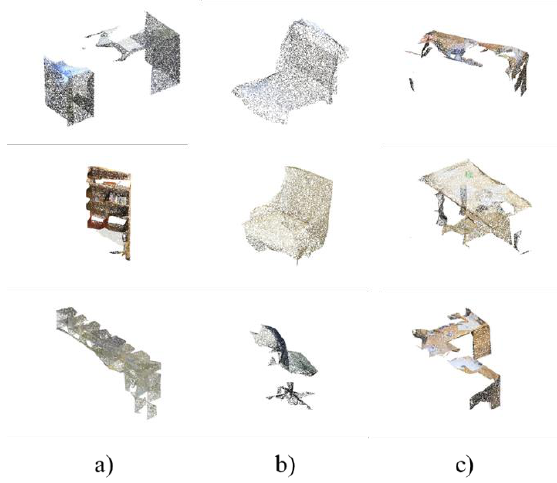
Figure 6. Samples with strong changes in intensity, occlusions and shape variation: a) bookshelves, b) chairs and c)